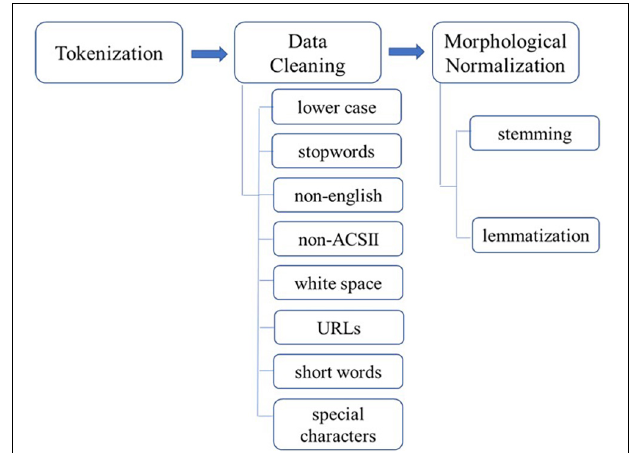
FIGURE 2 | Diagram of data